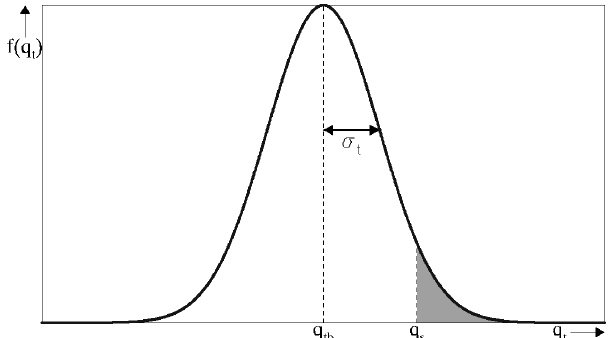
Fig. 2. Probability distribution function for total water content (blue Figure 2. Probability distribution function for total water content (blue line), with expectation 2 line), with expectation value q tb , and standard deviation σ t . The value q tb , and standard deviation σ t . The light shading corresponds to the area above the 3 light shading corresponds to the area above the saturated specific saturated specific humidity (denoted q s ), which contains cloud water. 4 5 humidity (denoted q s ) , which contains cloud